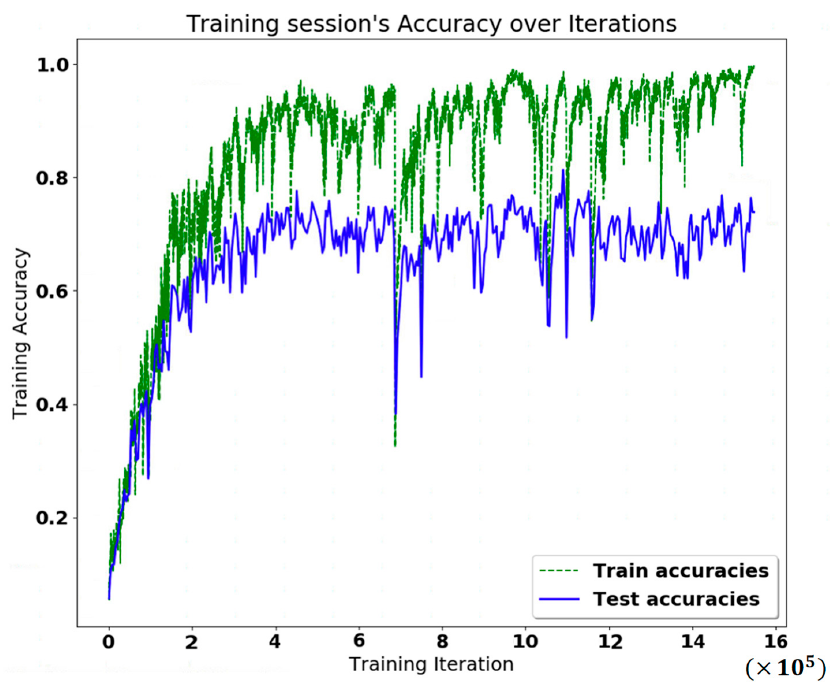
Figure 12. The accuracy of fps for each video. ( a ) Taking 30 frames as a group, the accuracy ( y -axis)